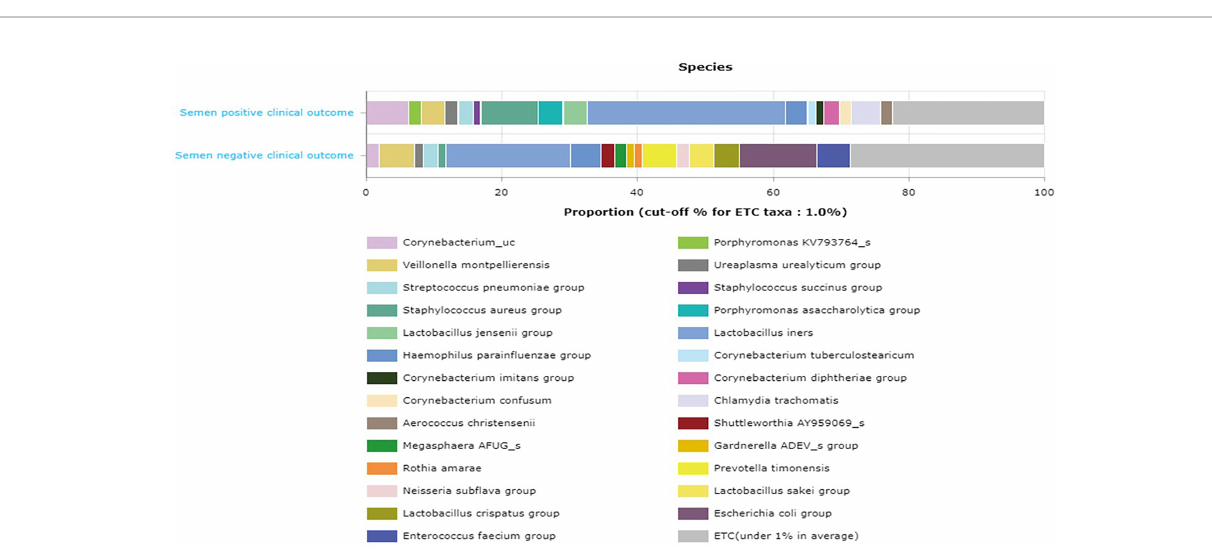
FIGURE 7 | Comparative proportion (cutoff 1.0%) of the relative abundance at the species taxonomic level between semen samples with positive IVF clinical outcome and samples with negative IVF clinical